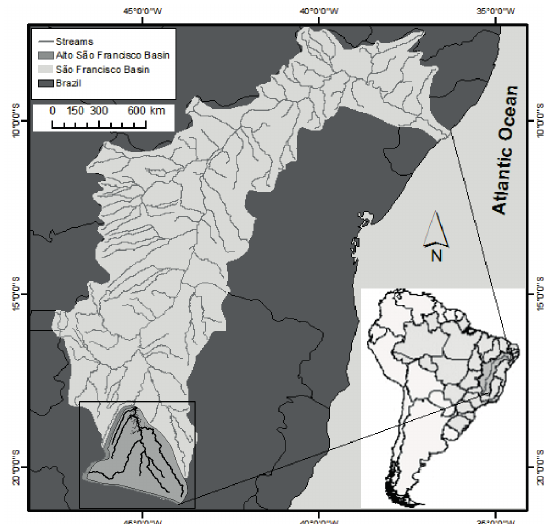
Fig. 1 Location of the São Francisco River basin and its sub-basin Alto do São Francisco,